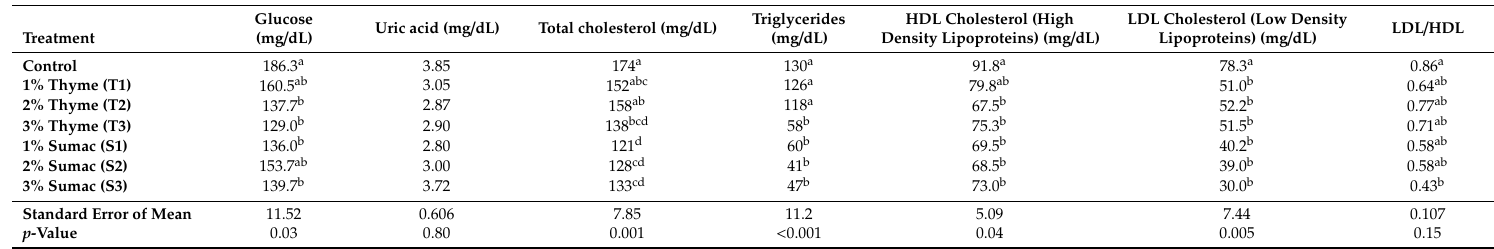
Table 6. Blood parameters of Ross 308 broilers at 42 days of age fed diets containing 0, 1, 2, and 3% thyme (T3) and sumac from days 29–42.